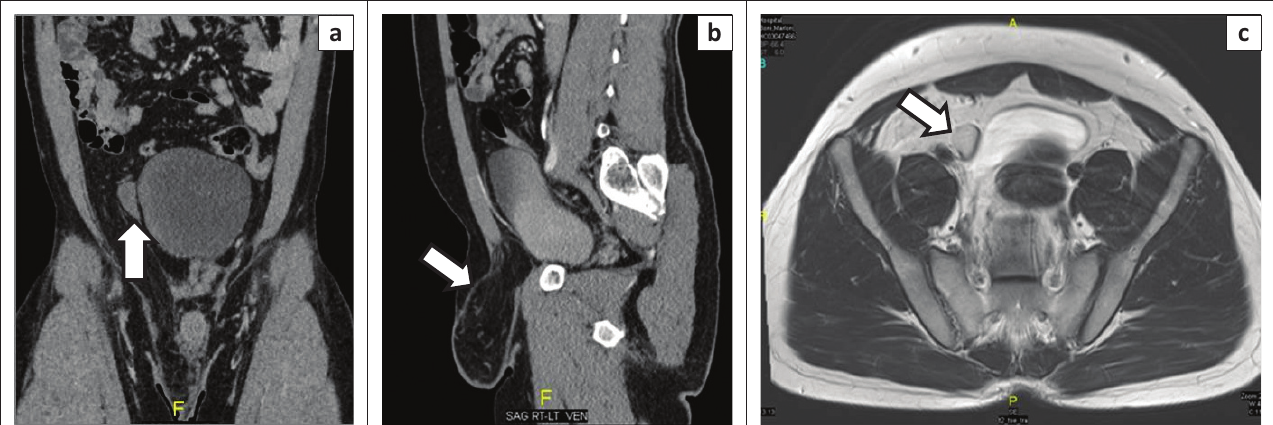
FIGURE 11: A 30-year-old male presented to the emergency department with pain in the right inguinal region with a large inguinoscrotal hernia on clinical examination: (a) Coronal and (b) sagittal images of a computed tomography abdomen demonstrated an undescended testis (arrow on image a) along its path in the right lower abdomen, located lateral to the surface of urinary bladder (U). There was an associated large right omental hernia (arrow on image b). (c) The undescended testis is hyperintense (arrow on image c) on axial T2-weighted magnetic resonance